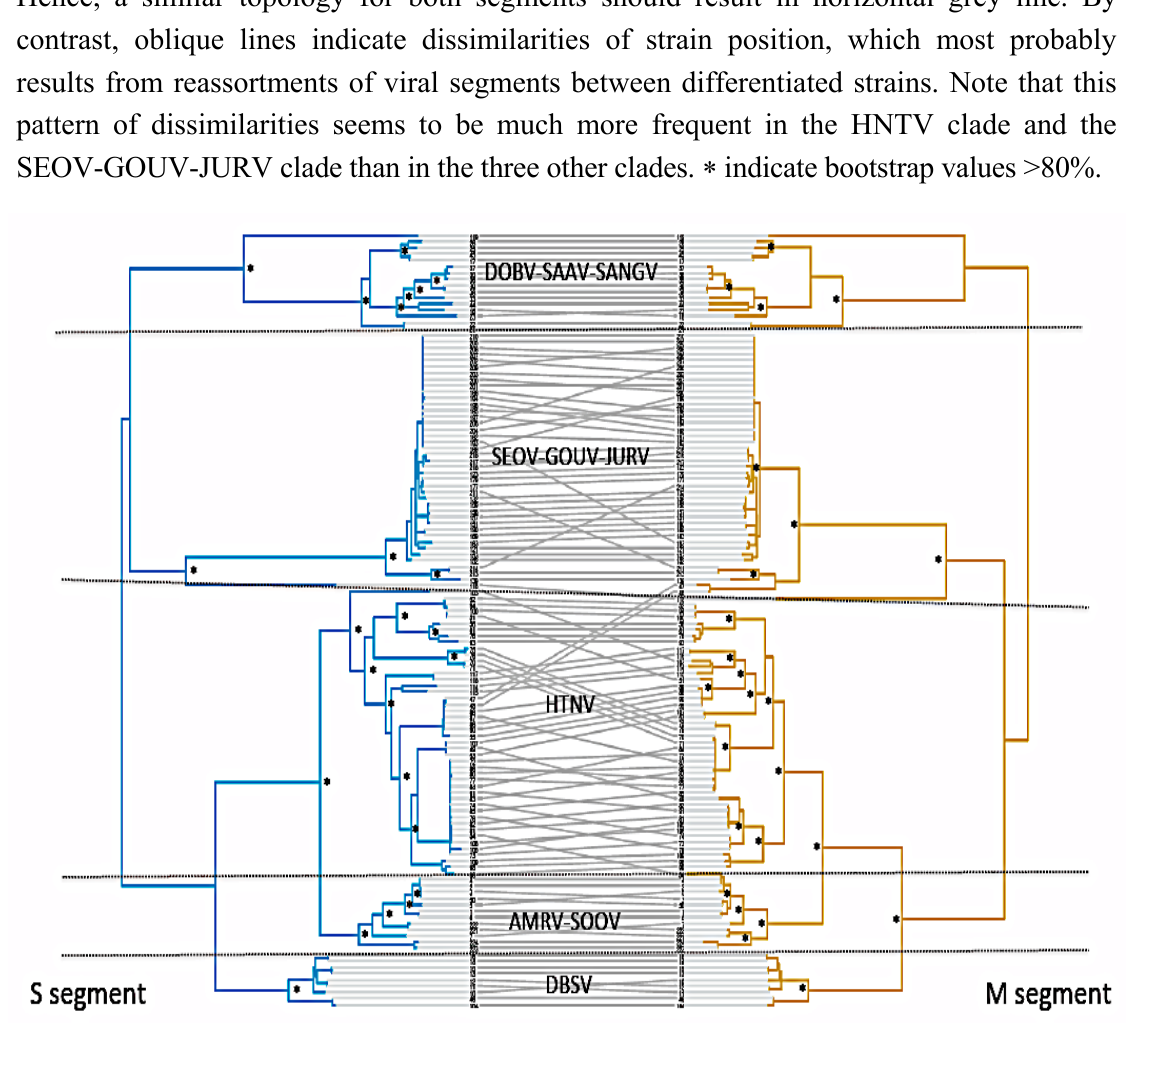
Figure 1. Tanglegram of the two phylogenetic trees based on analyses of segments M and S. Grey lines are used to illustrate the segments that were isolated from the same virus